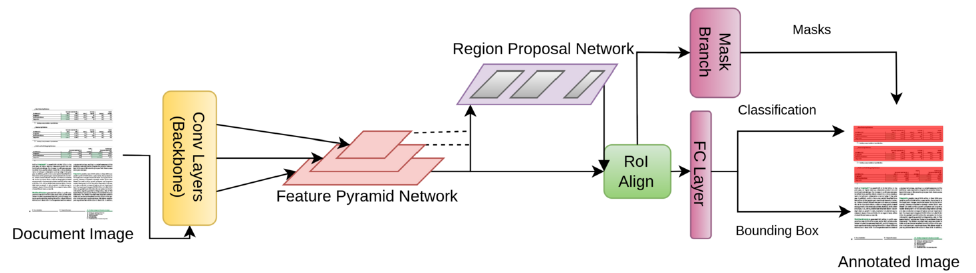
Figure 5. The detection pipeline for the Mask R-CNN detection head. Mask R-CNN extends Faster R-CNN to the image segmentation domain by adding the mask branch, which produces masks for semantic